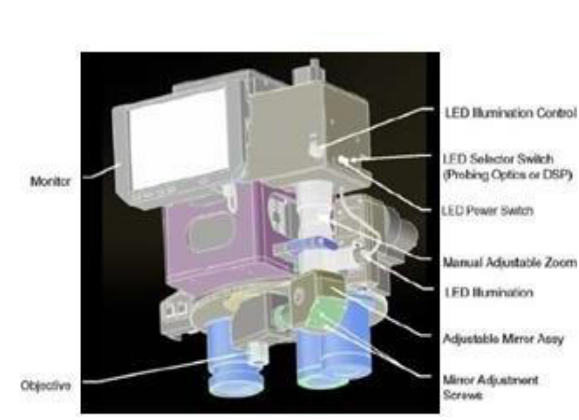
Fig. 2 . Thermal camera